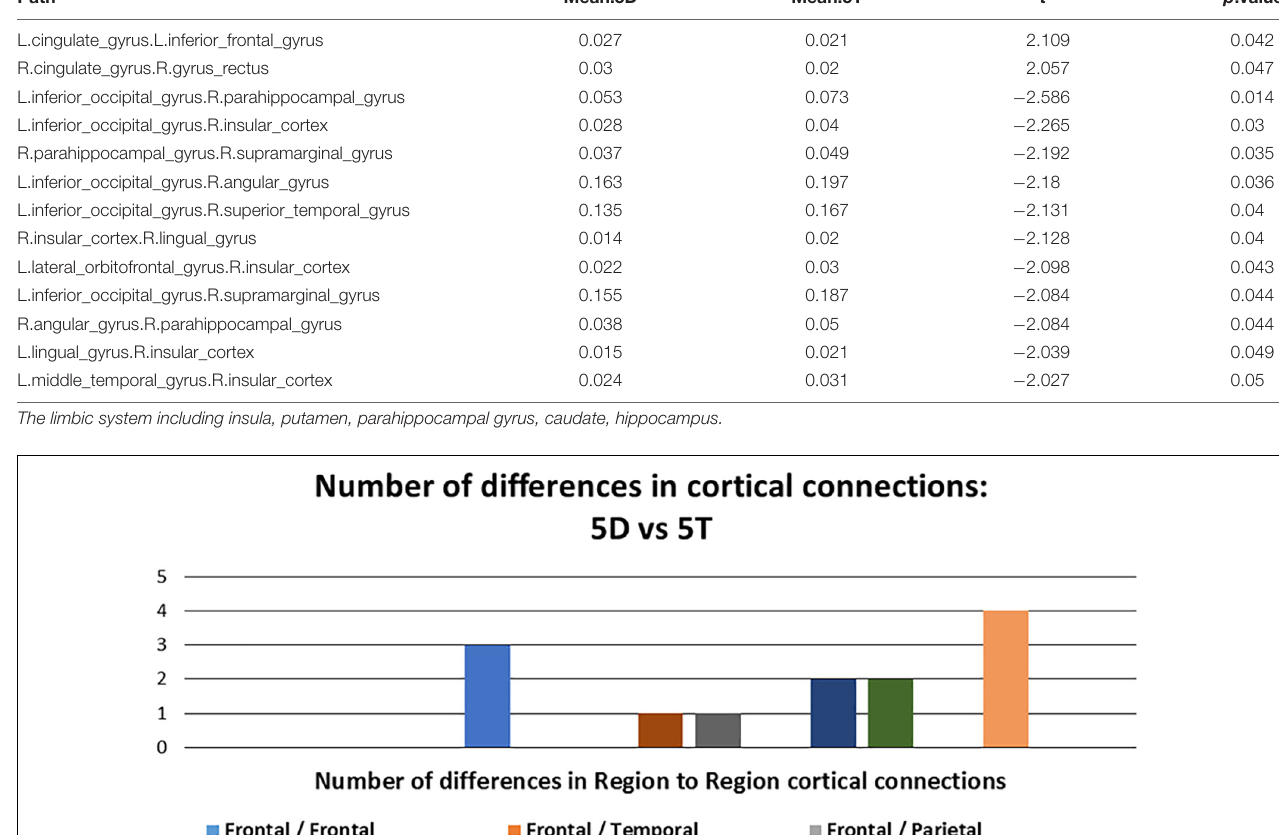
TABLE 3 | Differences in network activation: Five single-digit calculation (5D) versus five-note transposing (5T). Path